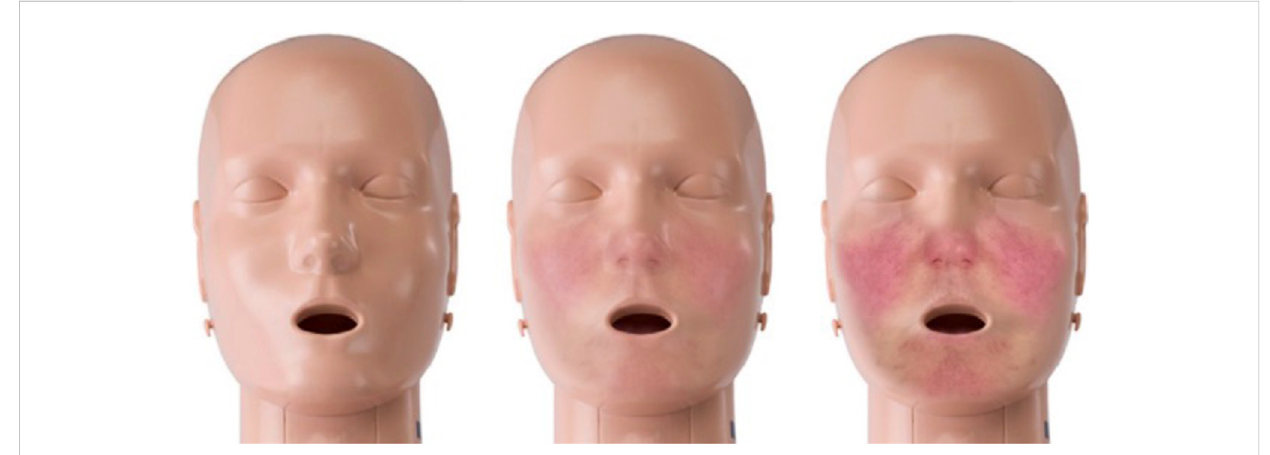
FIGURE 1 Thisisanexampleofthemanikinwithareal-imagebased fi ltersatdifferentstagesofdevelopment.Malarrashsymptomswerechosenforthisstudy because the butter fl y pattern of the facial rash is distinctive, the rash develops over time, and malar rashes can occur as a result of numerous different medical issues (Naji Rad and Vashisht,